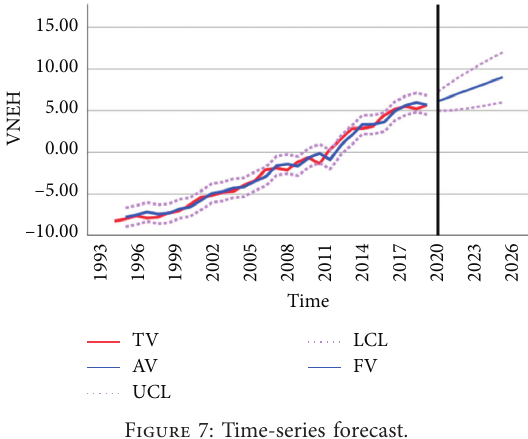
Figure 7: Time-series forecast. Table 6: Time-series forecast table.